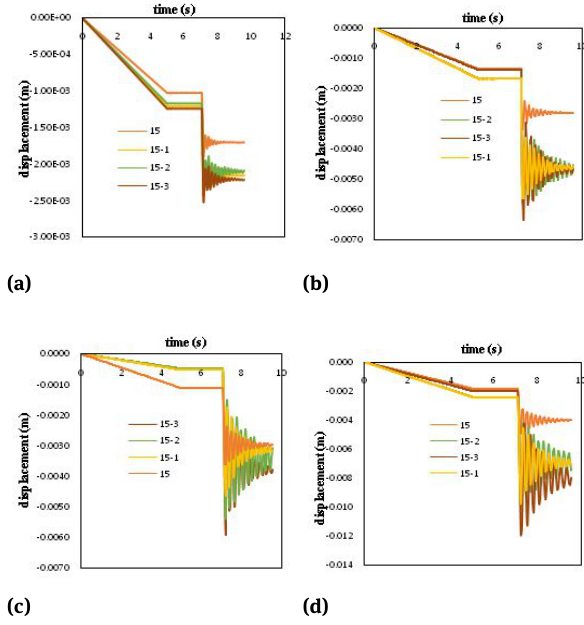
Figure 6: Nonlinear dynamic curves of 15-story structures, (a) D1-8 th Floor; (b) D3-8 th Floor; (c) G3-8 th Floor; (d) D3-12 th